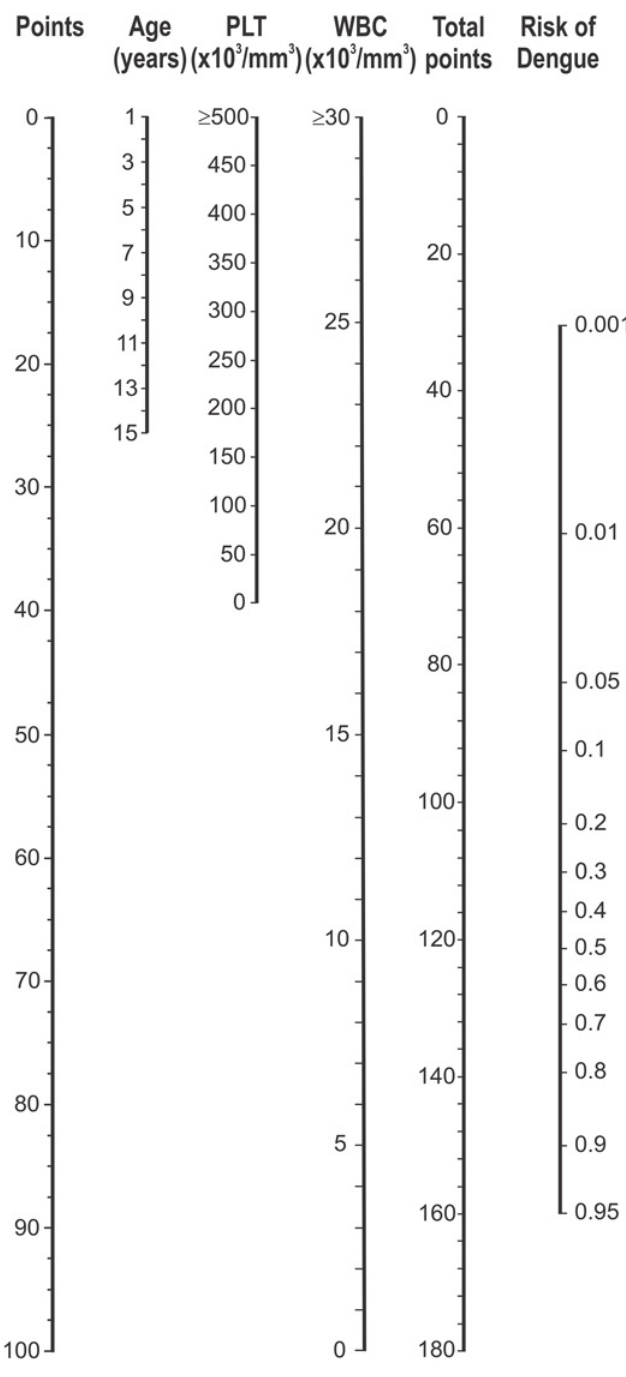
Fig 2. Nomogram of the Early Dengue Classifier (EDC) to predict the risk of dengue. A horizontal line from a predictor value to the “ Points ” axis assigns points to the 3 required variables age, platelet count (PLT), and white blood cell count (WBC). The sum of these points (total points) can then be translated to the corresponding predicted risk of dengue. As an example, a 9-year-old patient with a PLT of 100x10 3 /mm 3 , and a WBC of 5x10 3 /mm 3 has a score of 15+32+84 = 131, and the corresponding risk of dengue is about 70%. Note: As < 1% of patients had platelet (PLT) count > 500x10 3 /mm 3 or white blood cell (WBC) count > 30x10 3 / mm 3 , for better visualization, PLT and WBC counts were truncated at 500x10 3 /mm 3 and 30x10 3 / mm 3